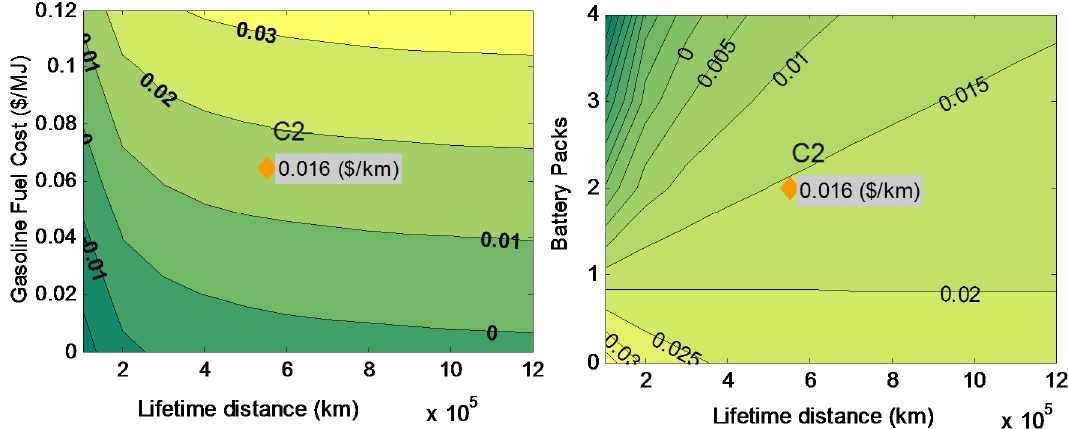
Figure 13. Financial gain considering the gasoline cost and the number of battery packs for the BL driving cycle, of optimal solution